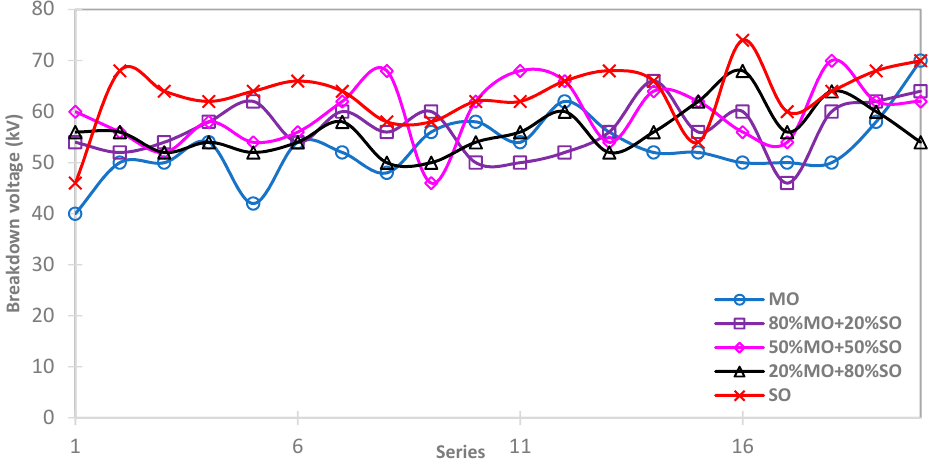
Figure 16. Distribution of breakdown voltages under DC of mineral (MO)/Synthetic oil (SO) mixtures.